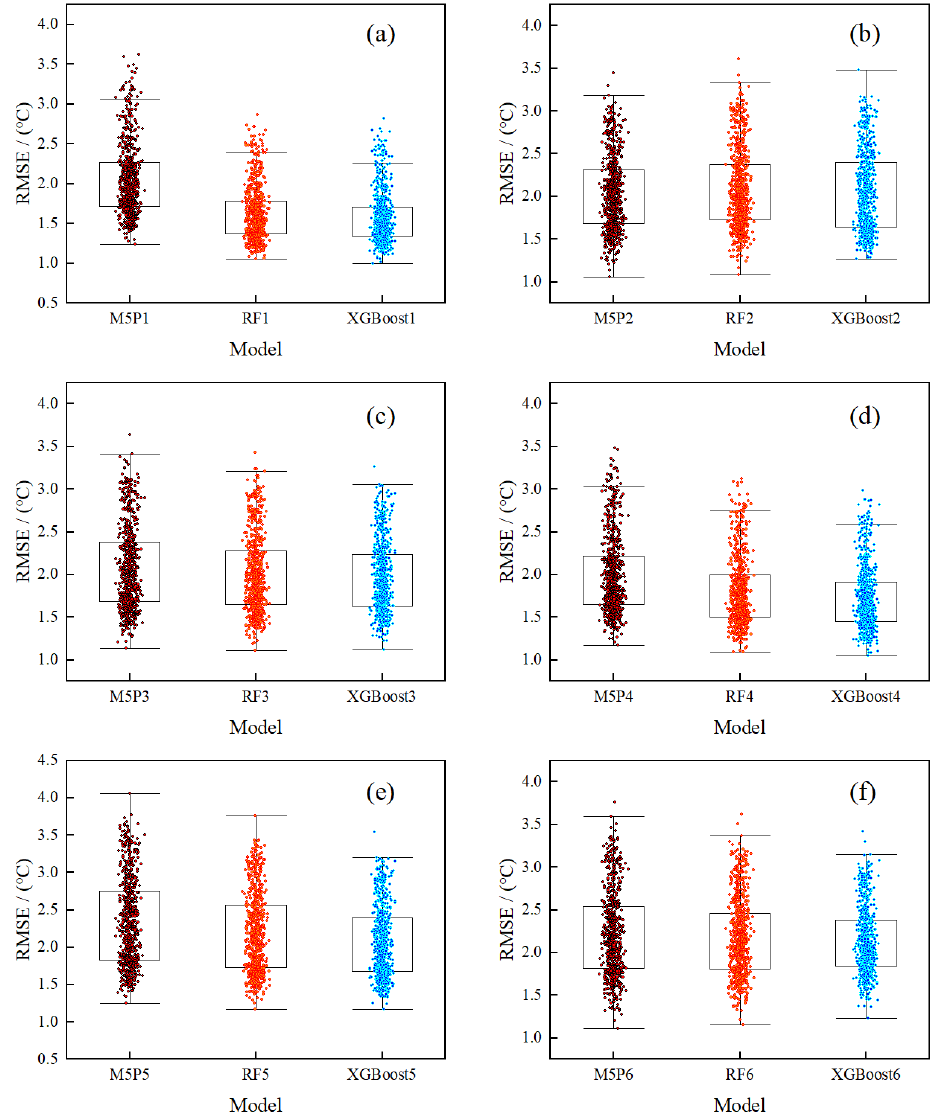
Figure 3. Box plots of the RMSEs of the three models for estimating T s under six input combinations ( a – f ).